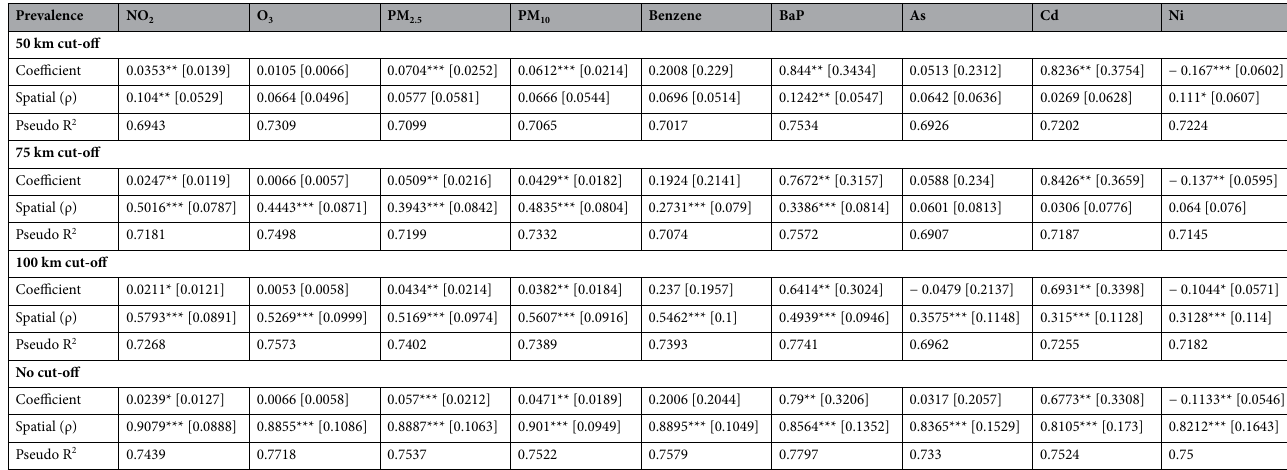
Table 15. Results from SAR models on COVID-19 prevalence registered on 28 February 2021. p-value < 0.01***; p-value < 0.05**; p-value < 0.1*. Standard errors in parentheses. All models included a constant and the following controls: dummies for regional capitals and national borders, size of the province, population aged 0–19, distance from nearest airport, share of foreigners, share of male population, population density, degree of urbanization, deaths due to LRT disease, smokers, obese individuals, large firms, altitude, and rainy days.